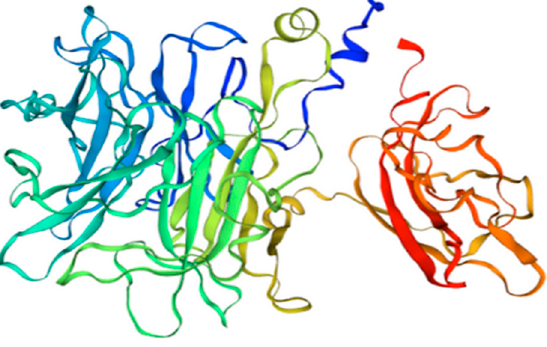
Figure 3. 3D model of tomato Sola l 2 structure. Homology Model based on nsLPT derived from Pachysandra terminali, Seq Identity 64.02%.